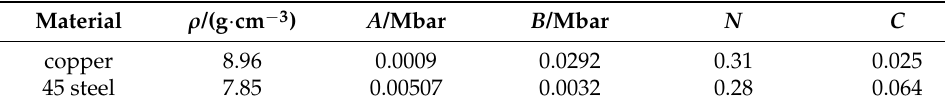
Table 2. Material Parameters of Copper and 45 Steel.